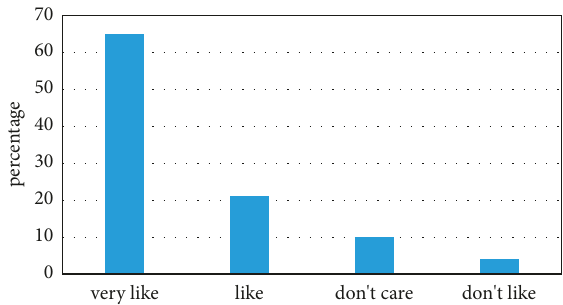
Figure 3: The degree to which the students enjoy their art design